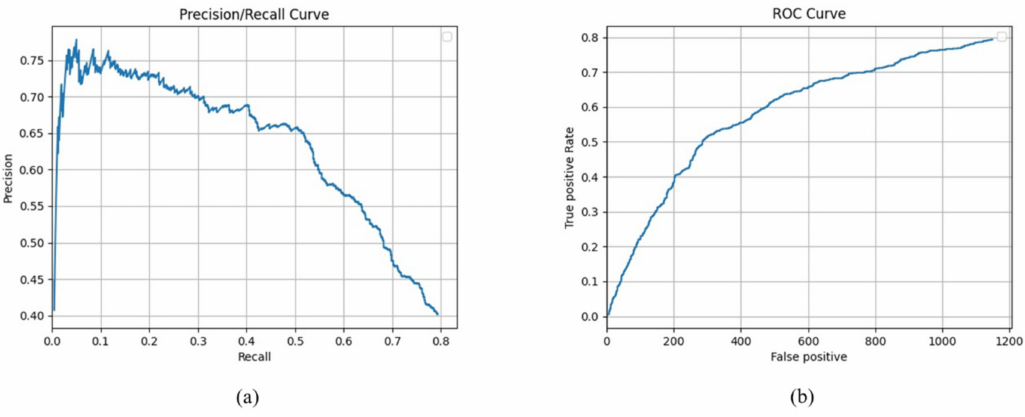
Figure 14. ( a ) PR curve and ( b ) ROC curve of the two-stage recognition